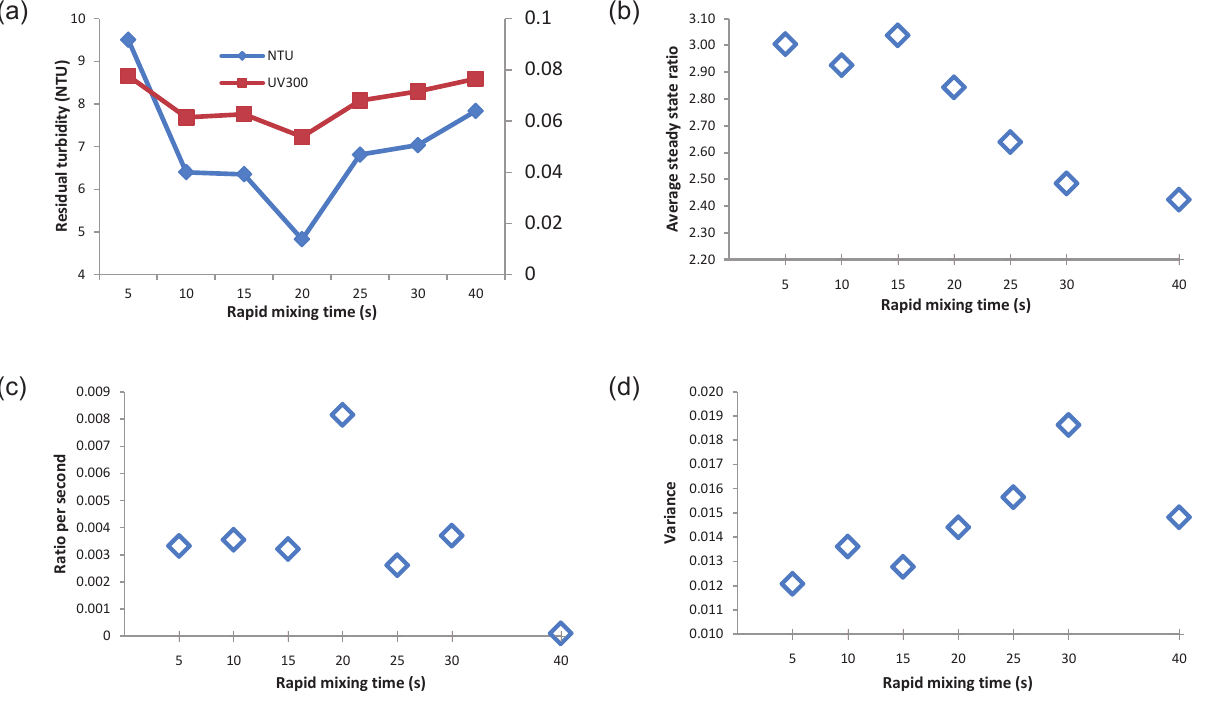
Figure 7. Optimization of rapid mixing time – (a) residual turbidity and colour; (b) average steady-state ratio; (c) aggregation rate; (d) steady-state